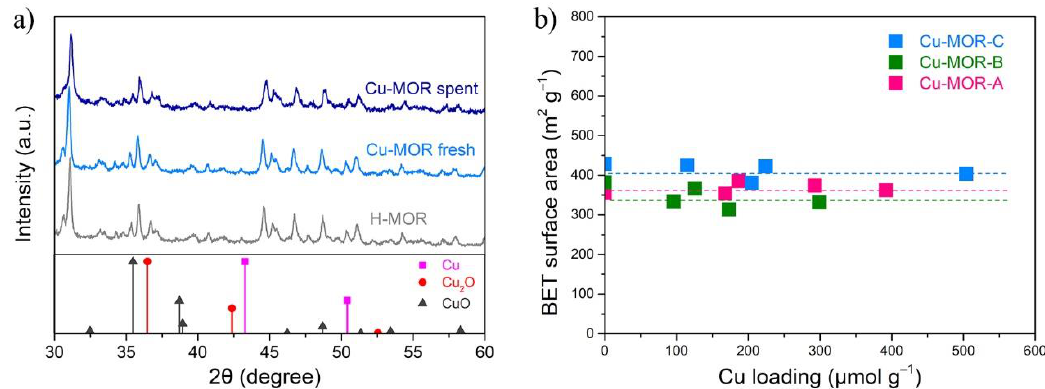
Figure 1. ( a ) Powder X-ray diffraction patterns for MOR and Cu-MOR samples (MOR-A, Si/Al = 14) with Cu (PDF-04- 0836), Cu 2 O (PDF-34-1354), and CuO (PDF-45-0937) as reference; ( b ) Surface area as a function of Cu loading for the Cu- MOR catalysts.